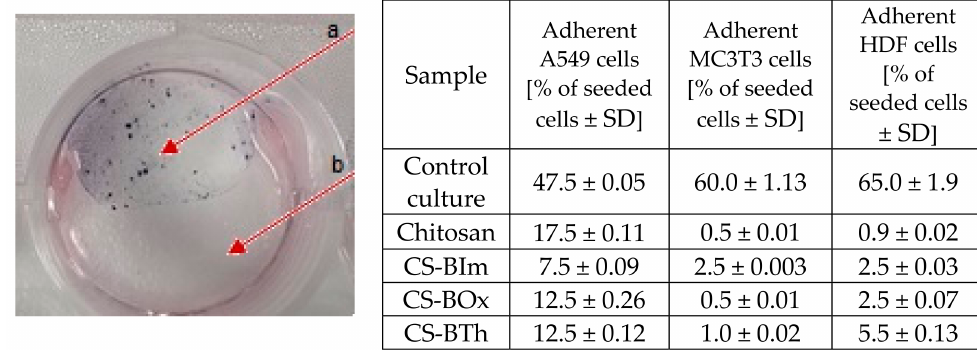
Figure 7. Representative example of a cytotoxicity test on a modified chitosan sample. Arrow a shows the violet formazan crystals formed from MTT (see text for details) in viable HDF cells growing on a chitosan-free surface; arrow b : cell-free chitosan layer. Table: adhesion test after 24 h culture on different CS